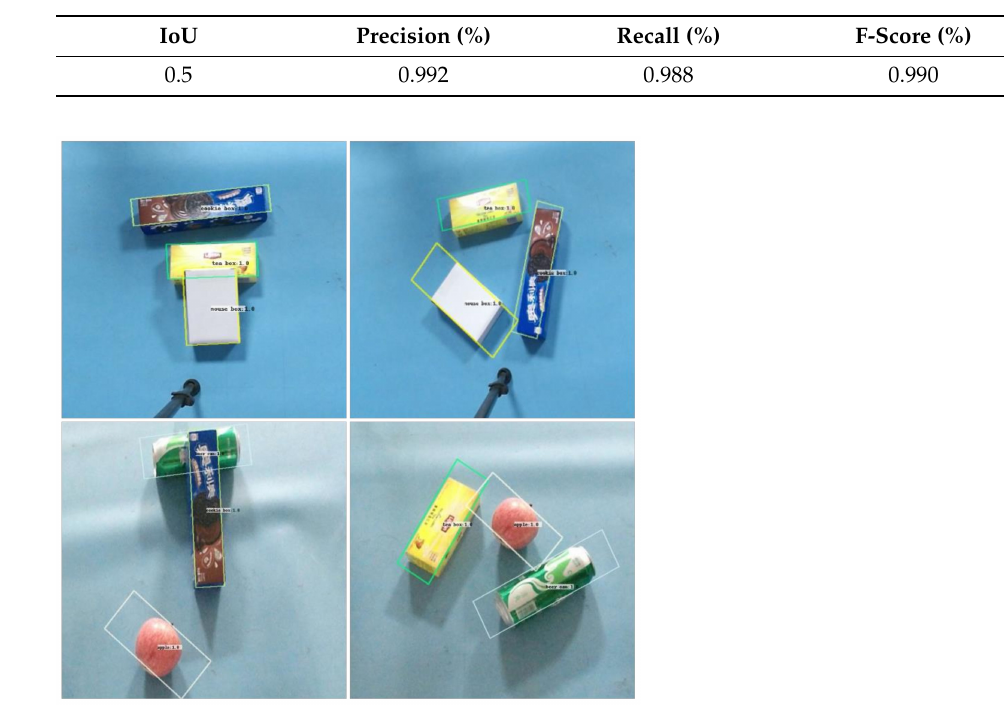
Figure 7. Curve diagram of overall training loss. Table 1. Detection results of rotating target detection network.